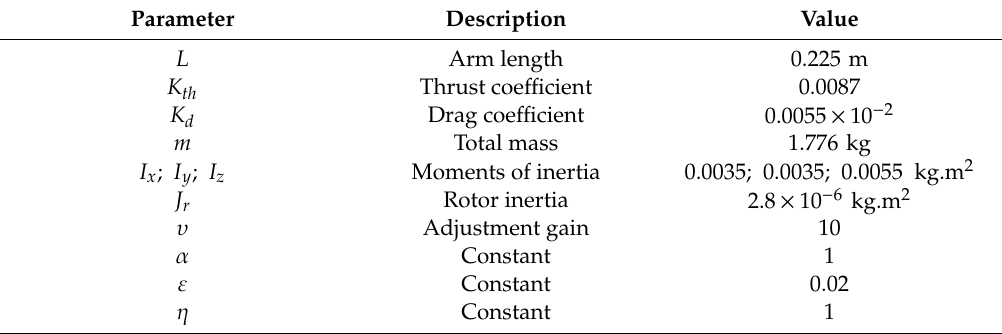
Figure 2. Flight test procedure. Table 2. DJI F450 quadcopter parameters and observer design values.